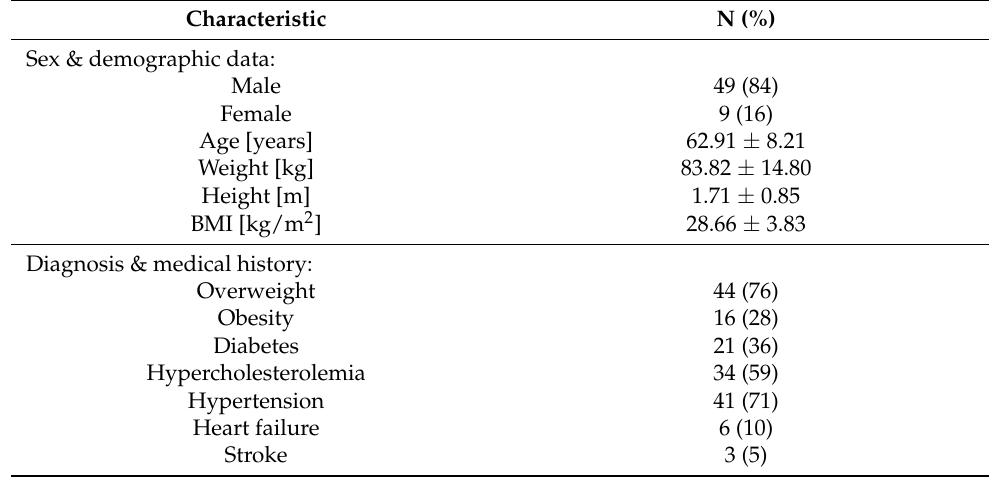
Table 1. Characteristics of patients. Values are given as the number of patients N (%) or mean ± SD. Characteristic N